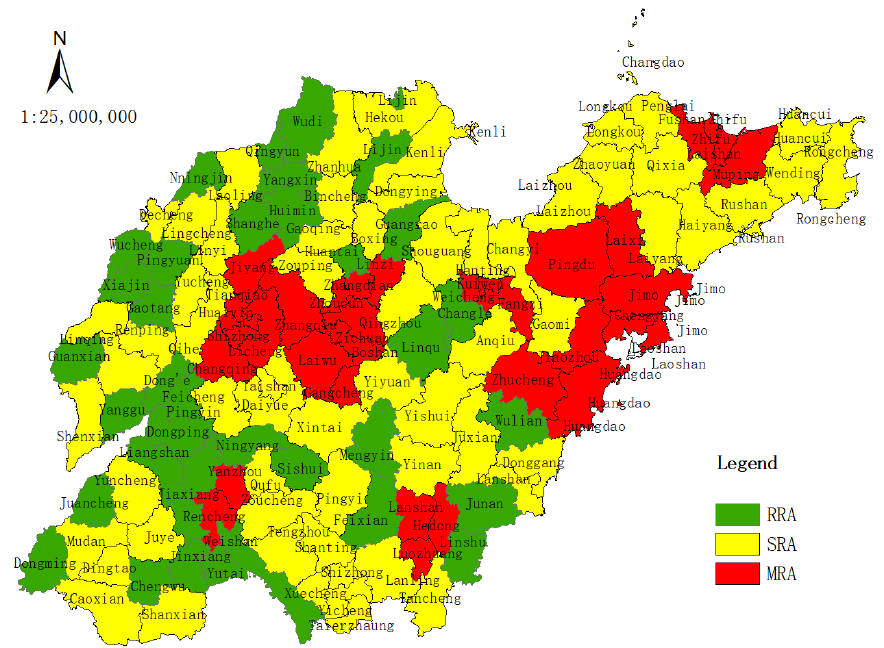
Figure 4. The distribution of different types of rural areas.